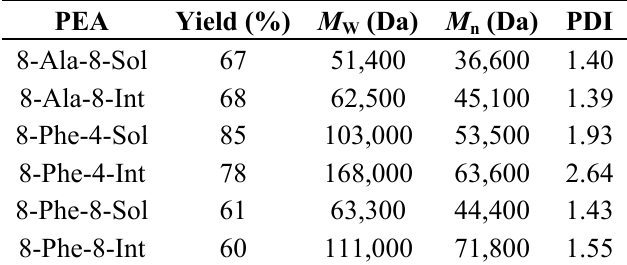
Table 1. Comparison of solution and interfacial polycondensation of AABBP (according to